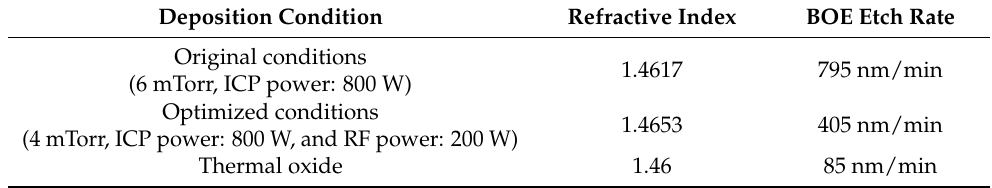
Table 2. BOE etch rate and refractive index of SiO 2 films prepared under various